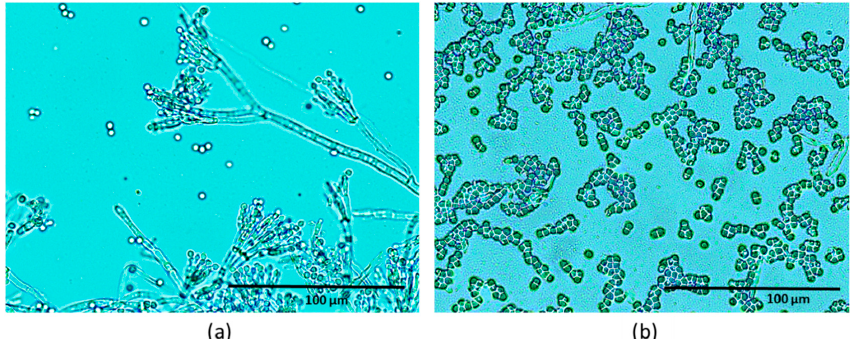
Figure 4. Microscopical image of Penicillium nalgiovense Pj261 in the absence ( a ) and presence ( b ) of the antifungal protein PgAFP after 15 days of incubation at 25 °C and 0.97 water activity in a dry-cured fermented (salchichón)-based medium.